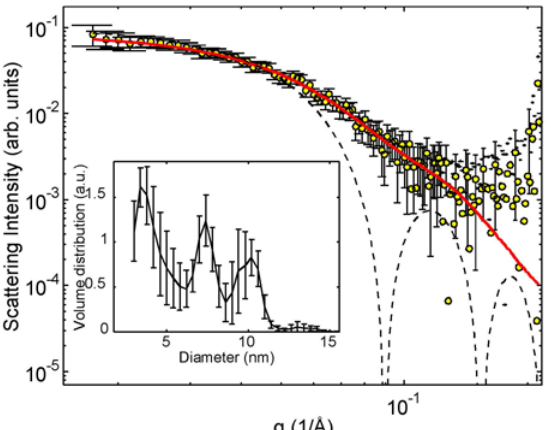
Figure 6. The scattering pattern of initial sample (yellow symbols) and theoretical scattering from a sphere with a diameter of 10 nm (dashed line). The inset shows the Monte Carlo (MC) simulated volume distribution of spheres in arbitrary units. It corresponds to the fit (full red line). See text for details.